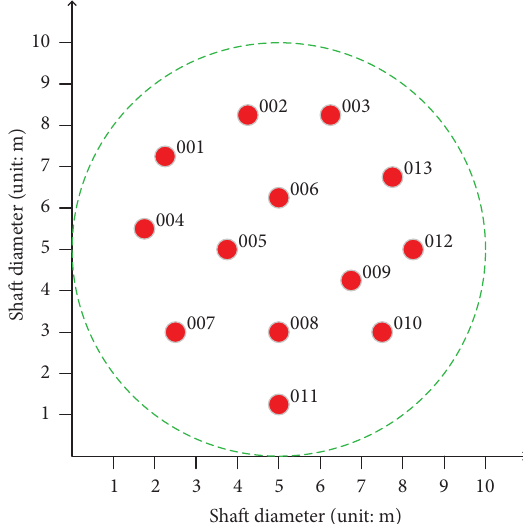
Figure 15: The plane position of detonator